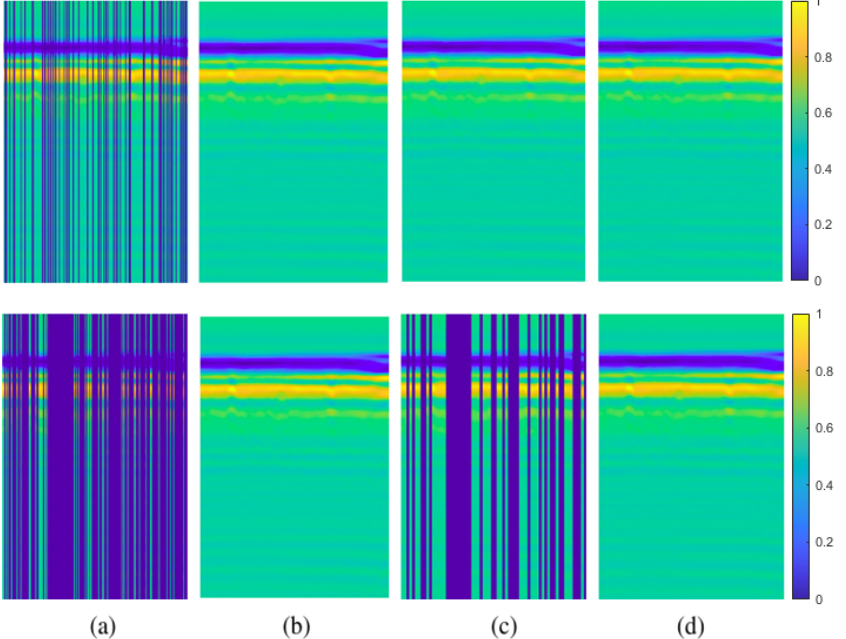
Figure 18. First row 30% and second row 80% column-wise missing data case for real data-I: ( a ) GPR image with missing entree, ( b ) original GPR image, recovered images by ( c ) NNM, ( d ) DIP.